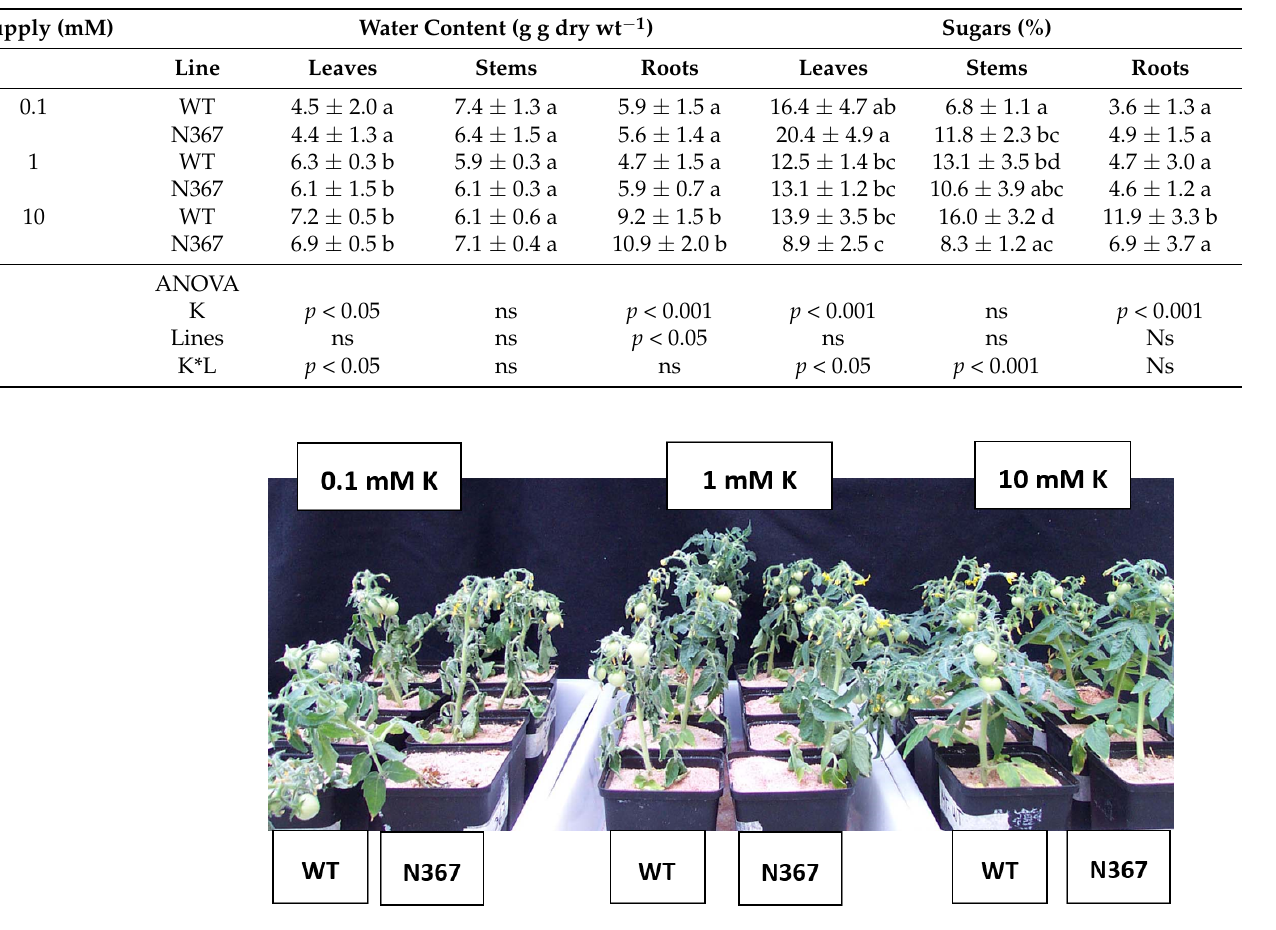
Table 7. Effect of available K on sap flow (J v ), root hydraulic conductivity (L 0 ) and xylem sap K concentration in hydroponically grown tomato lines WT and N367 at flowering stage. Means fol- lowed by the same letter are not significantly different (LSD Test, p < 0.05). K and L in ANOVA represent potassium and line factors, respectively.